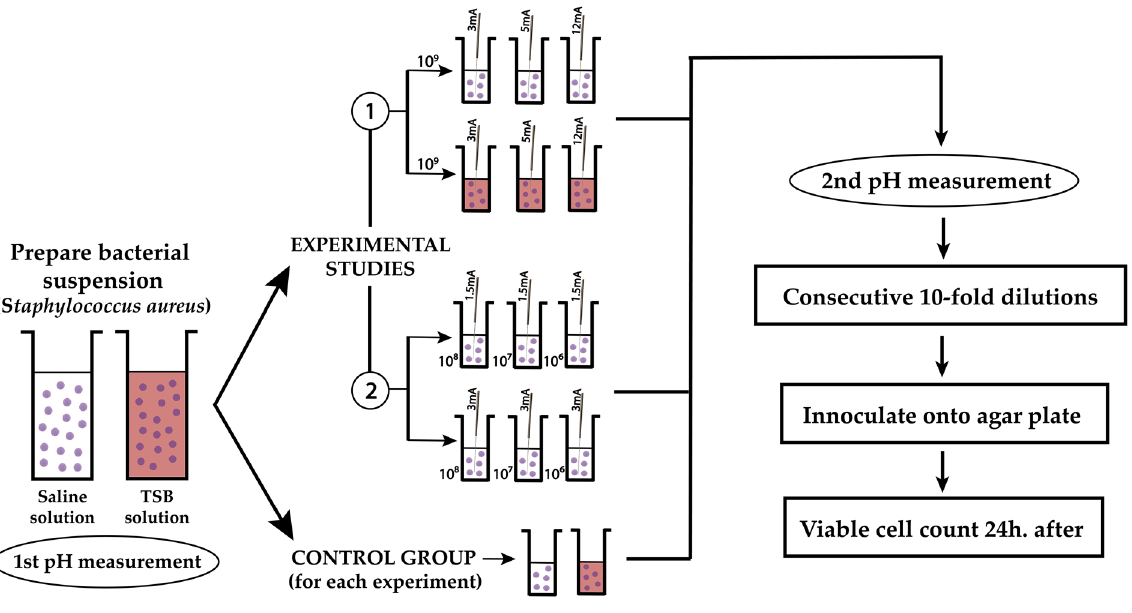
Figure 1. Flow-chart of the experimental